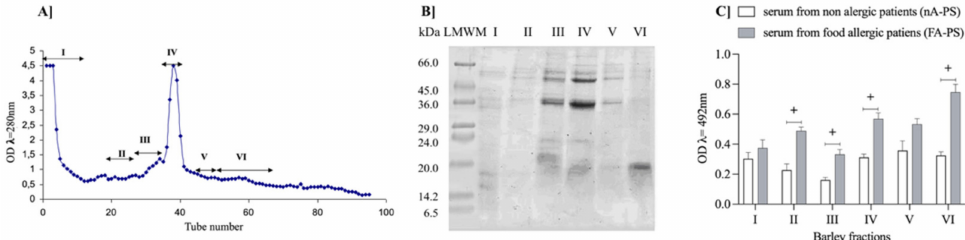
Figure 3. ( A ) Elution profiles of crude protein extract (cBP) from barley grains on the ion-exchange DEAE-Sepharose column; ( B ) SDS-PAGE protein patterns of eluted fractions I–VI (MWS, molecular weight standard); and ( C ) the IgE immunoreactivity of barley fractions I–VI. The OD value was considered a positive response with food-allergic patients’ serum (+) if it exceeded the mean of the controls (non-allergic patients’ serum) by more than three standard deviation